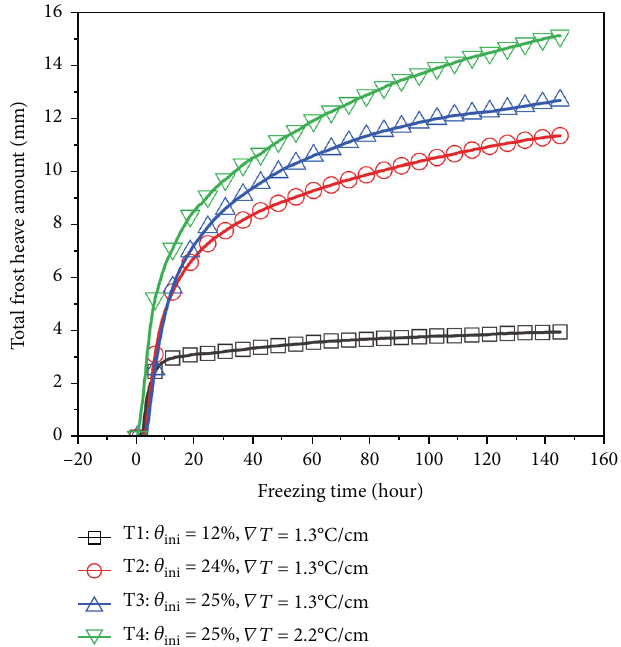
Figure 10: The total frost heave amount changes in the soil columns.